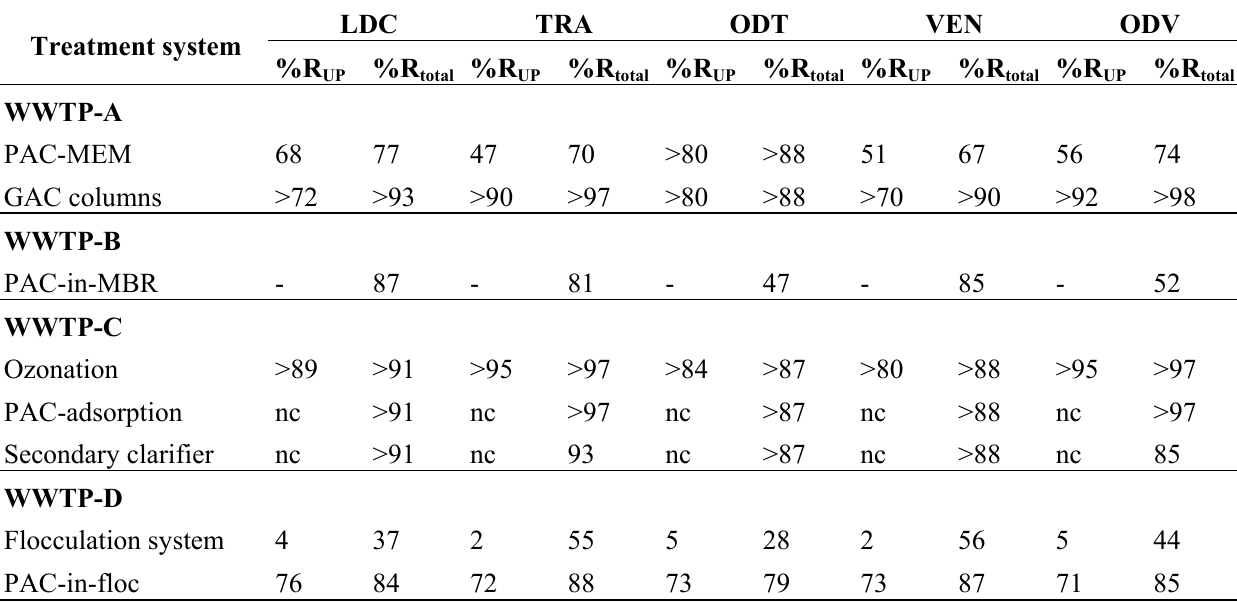
Table 5. Percentage of removal of the target analytes obtained by the unconventional treatment systems at the investigated